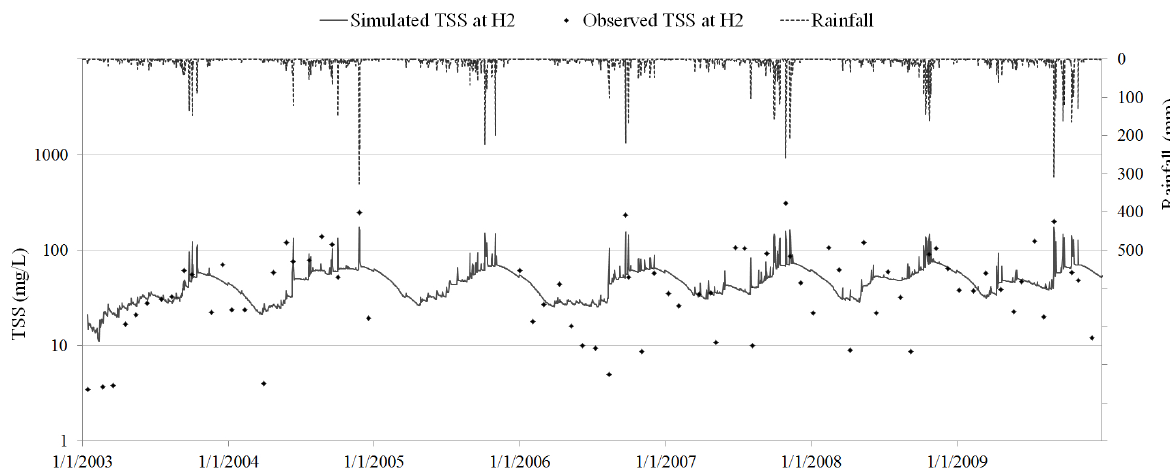
Figure 10. TSS validation at H2.